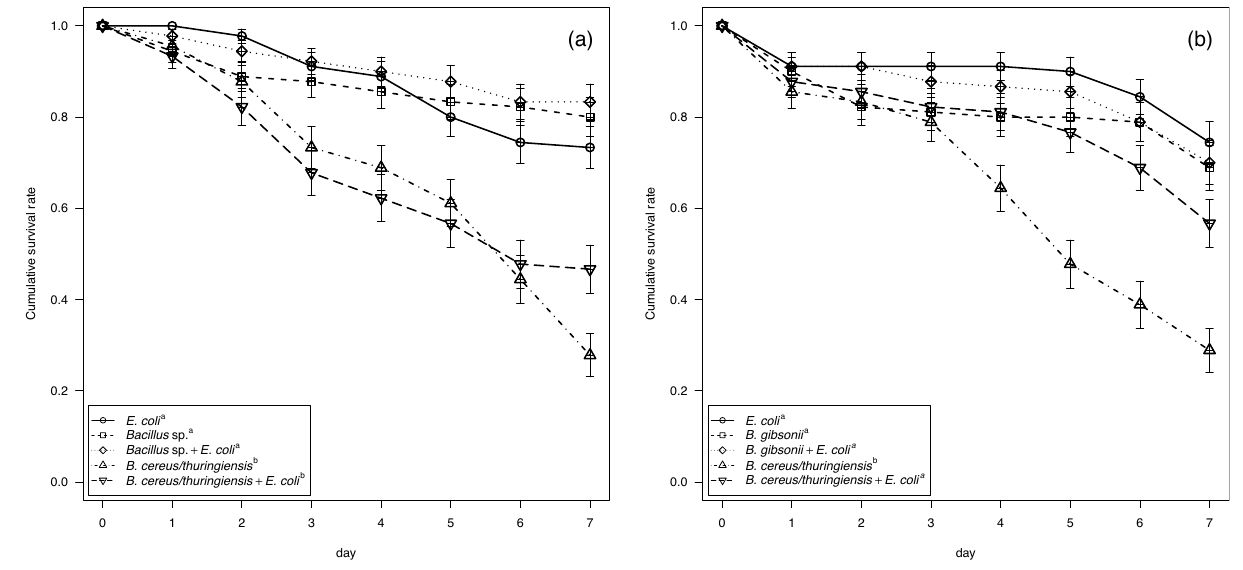
Figure 3. Daily cumulative survival rate (% ± SE) of the nematode, Caenorhabditis elegans , co-cultured with hemolytic and non-hemolytic bacteria isolated from ant cadavers of ( a ) the principal host, Polyrhachis moesta , and ( b ) the alternative host, P. wolfi , infected with Ophiocordyceps unilateralis sensu lato. Bacillus strains used in the examination were JYCB227 in clade m4 ( B. cereus/thuringiensis ) and JYCB252 in clade m8 ( Bacillus sp.) from P. moesta , and JYCB302 in clade w4 ( B. cereus/thuringiensis ) and JYCB395 in clade w30 ( B. gibsonii ) from P. wolfi . Letters indicate significant pairwise differences among the treatments (Tukey’s all-pair comparisons using the beta regression model, p <